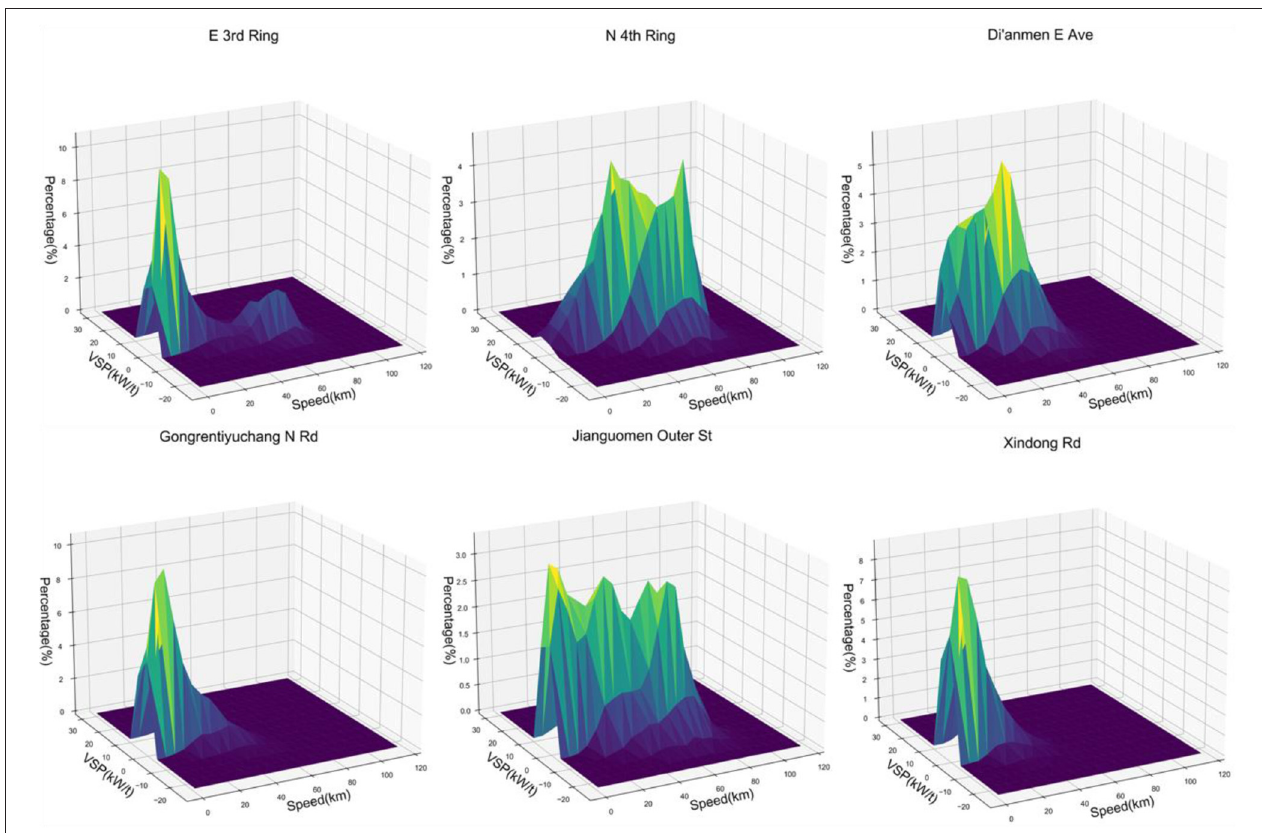
FIGURE 9 | VSP distribution curve for some typical roads in four regions.